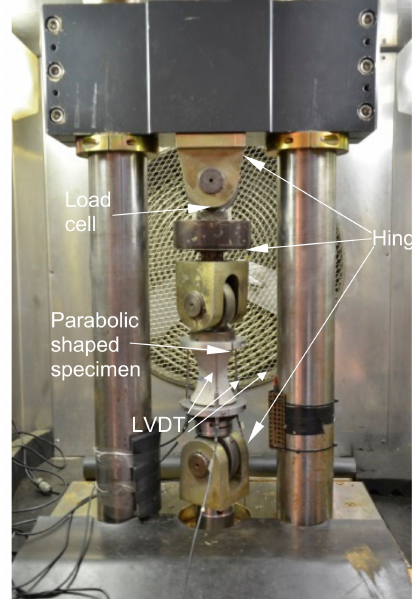
Figure 3. The TU Delft Uniaxial tensile test set